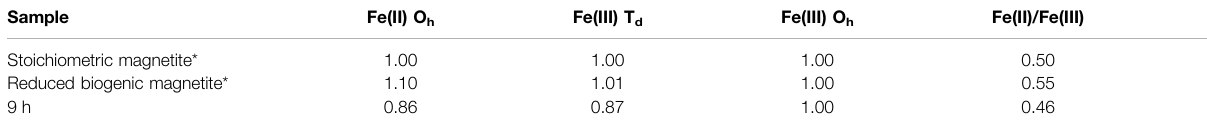
TABLE 1 | Fe site occupancies for biogenic materials calculated from XMCD ( Figure 2B ). * From Coker et al. (2007). Sample